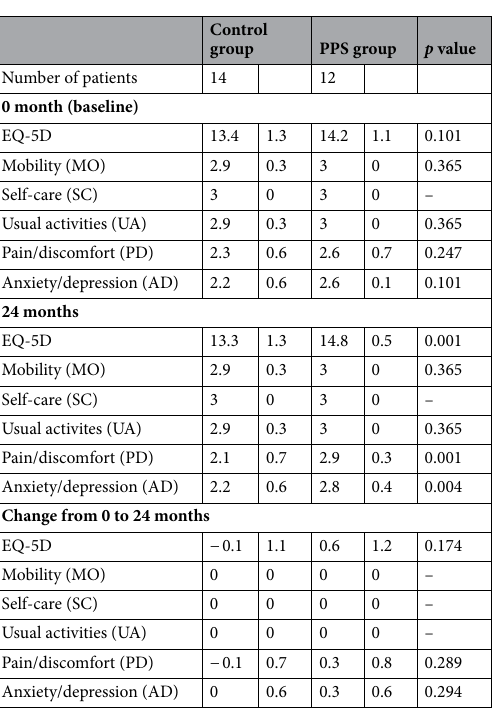
Table 2. Comparison of the EQ-5D-3L scores by domain between two groups. Data are mean (SD); or n (%). *Statistical analyses were carried out using Student’s t-test to compare means between the patient